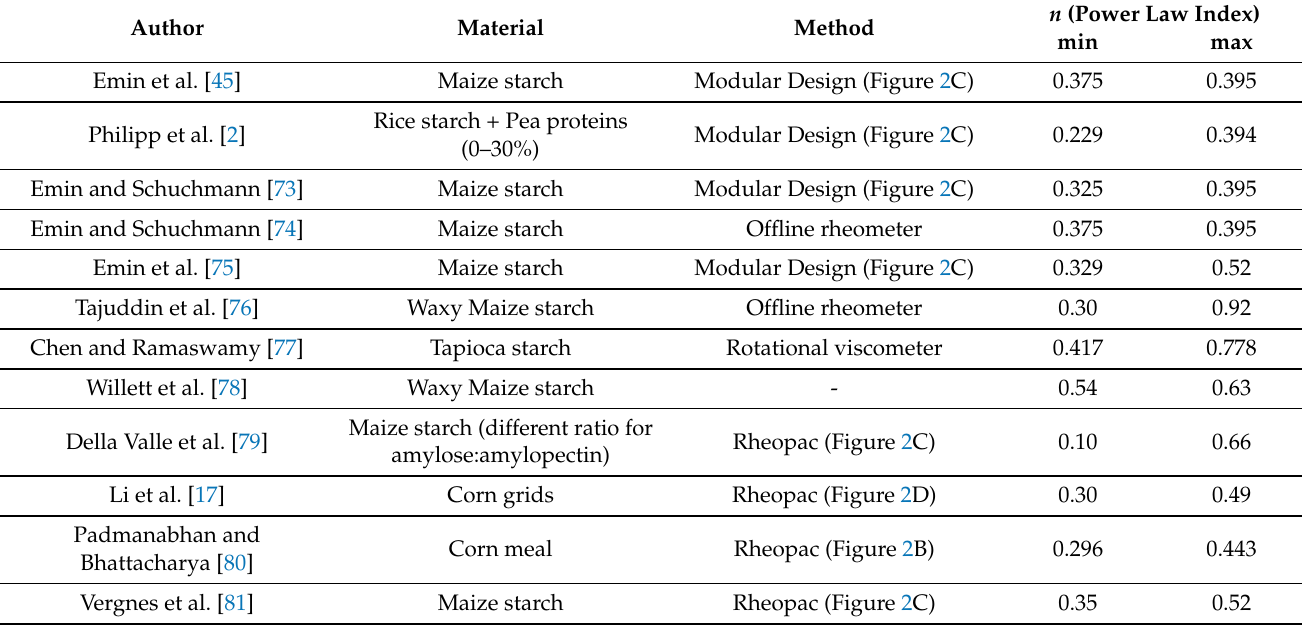
Table 1. Typical values for the power-law index ( n ) reported for extruded starch-based